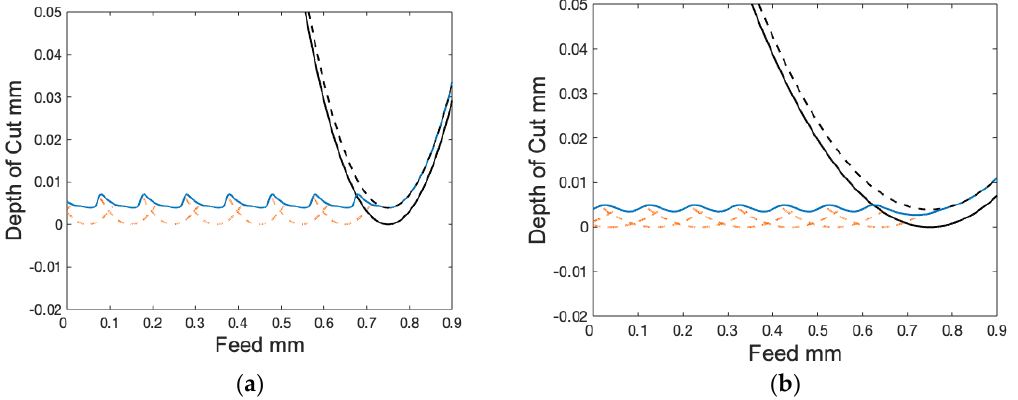
Figure 14. ( a ) Model-generated surface geometry showing the tool profile projection path and light overlapping of previous tool paths, modeled with r c = 0.4 mm, h min = 5 µm, and f = 0.1 mm; ( b ) model-generated surface geometry showing heavy overlapping of previous paths (multi-path condition), modeled with r c = 1.6 mm, h min = 5 µm, and f = 0.1 mm.